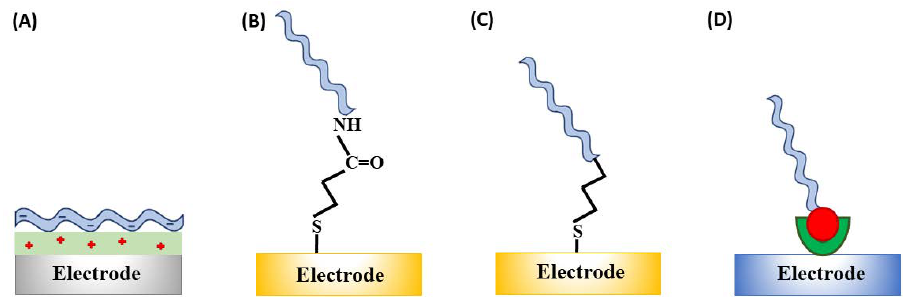
Figure 3. Immobilisation strategies for the aptasensor construction: ( a ) Physical adsorption of, e.g., negatively charged aptamer on the positively charged surface (e.g., polymer modified); ( b ) co- valent attachment through the EDC/NHS ((1-ethyl-3-(3-dimethylaminopropyl)carbodiimide/N- hydroxysuccinimide) coupling between COOH-functionalised electrode surface and the amine- terminated aptamer sequence; ( c ) chemisorption on gold through the alkanethiol linker; and ( d ) through affinity (streptavidin-biotin)